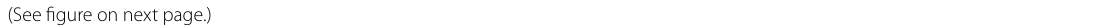
(See figure on next page.) Fig. 4 Transcriptome analysis of nasopharyngeal samples of patients with COVID-19 versus non-viral and other viral acute respiratory illnesses (ARIs) as well as healthy controls: The volcano plot to demonstrate differential expressed genes which had adjusted P -value < 0.05, |Log 2 FC|> 1. Red and green show up and downregulated genes, respectively ( A ). Dot plots to show BPs according to significantly up/downregulated genes ( B ) and hallmark gene set enrichment analysis ( C ). The size of the dots is proportional to the gene ratio in considering process and pathway; and the color corresponds to the –log10 of the adjusted P -value. Selected top and not-redundant terms are visualized. BP biological